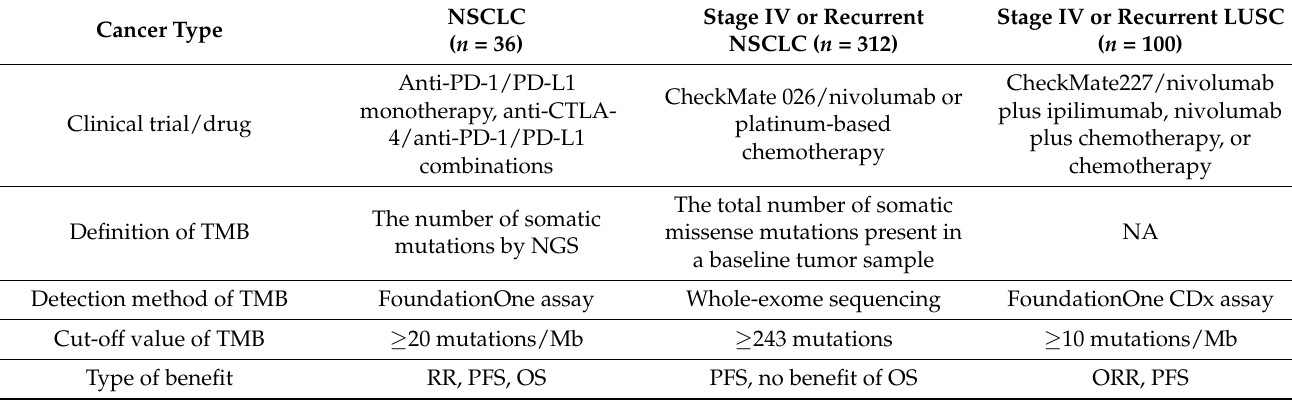
Table 5. Overview of published studies assessing tumor mutational burden (TMB) in